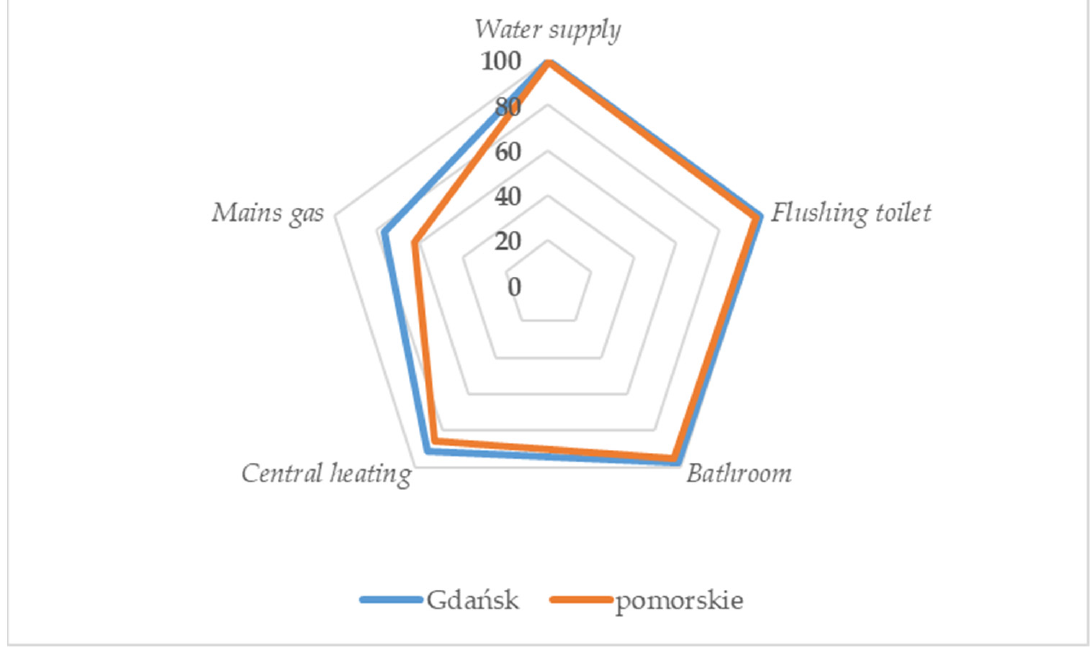
Figure 5. Indicators of housing infrastructure quality in Gda ń sk and the Pomeranian Province.